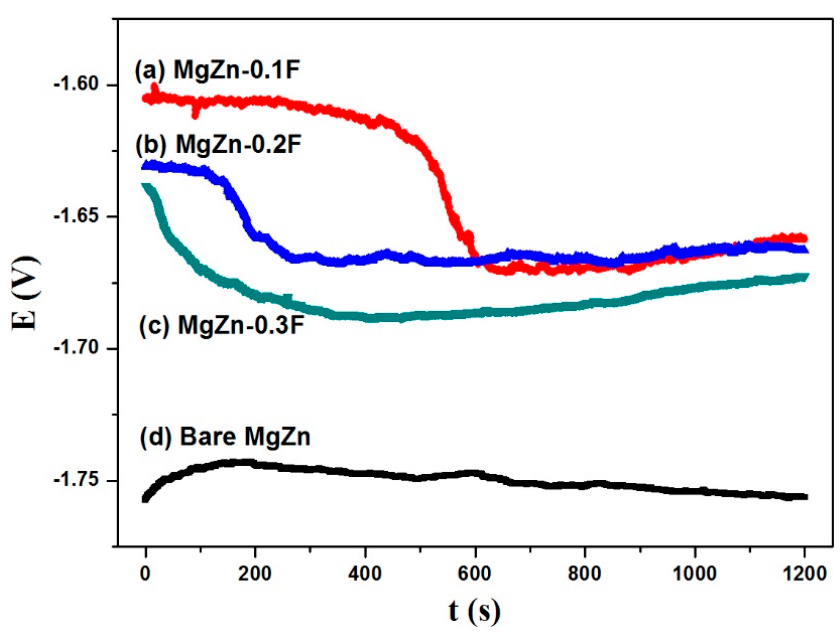
Figure 7. Open-circuit potential (OCP) curves of: (a) MgZn–0.1 F; (b) MgZn–0.2 F; (c) MgZn–0.3 F; (d) bare MgZn substrate.